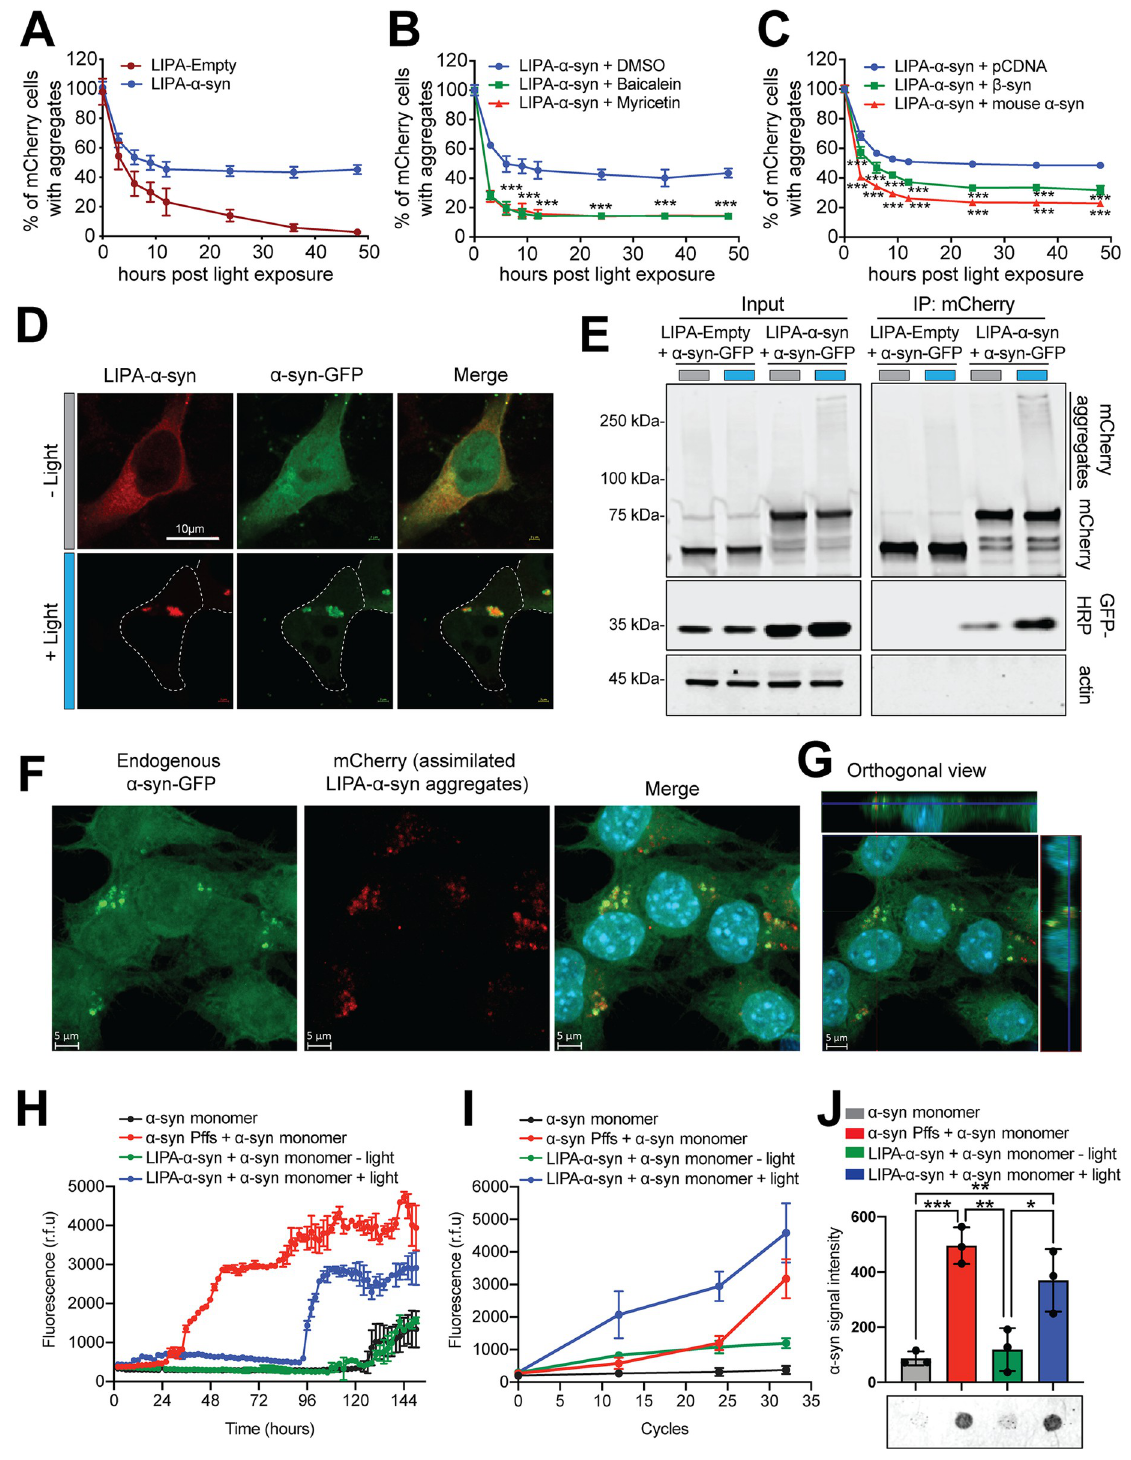
Fig 3. The LIPA system initiates stable and self-perpetuating α -syn aggregates through the seeding effect. ( A ) Time course of LIPA-Empty and LIPA- α -syn aggregate dissociation after 12 hours of preexposure to blue light. The data are presented as the percentage of mCherry-positive cells exhibiting inclusions over the total number of mCherry-positive cells normalized to the number of mCherry- positive cells exhibiting inclusions at time zero, which is set as 100% ( n = 5). ( B ) Impact of treatment with baicalein and myricetin, small- molecule inhibitors of α -syn aggregation, on LIPA- α -syn aggregate stability ( n = 4). ( C ) Effect of β -syn and m α -syn overexpression on